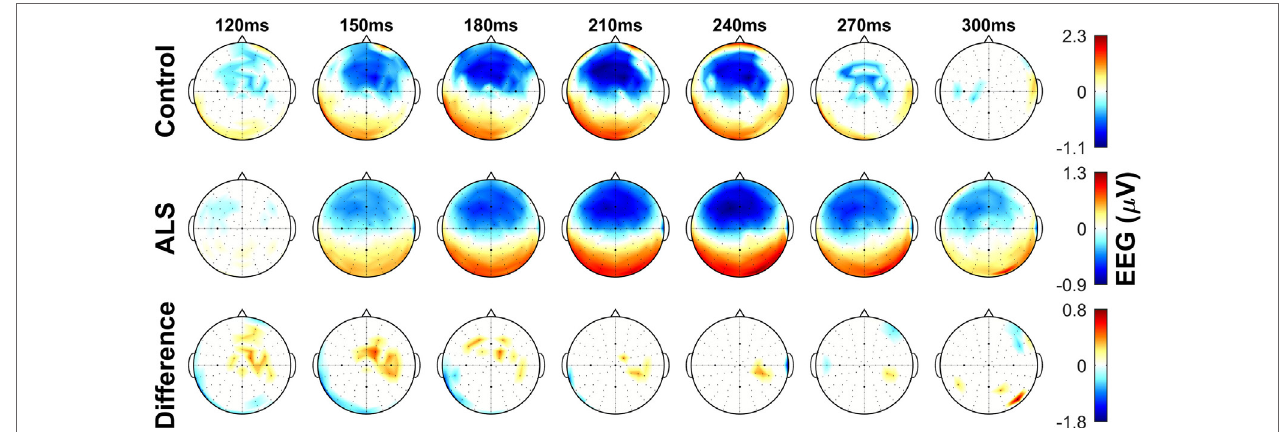
FigUre 3 | Topographic maps showing the mismatch negativity (MMN) in controls and amyotrophic lateral sclerosis (ALS) patients, as well as the between-group differences in frontocentral regions. Notice the overall time shift of MMN in the ALS group. Non-significant ( p > 0.05) values of MMN in each group and their between-group difference are shown as 0. See text for statistics and